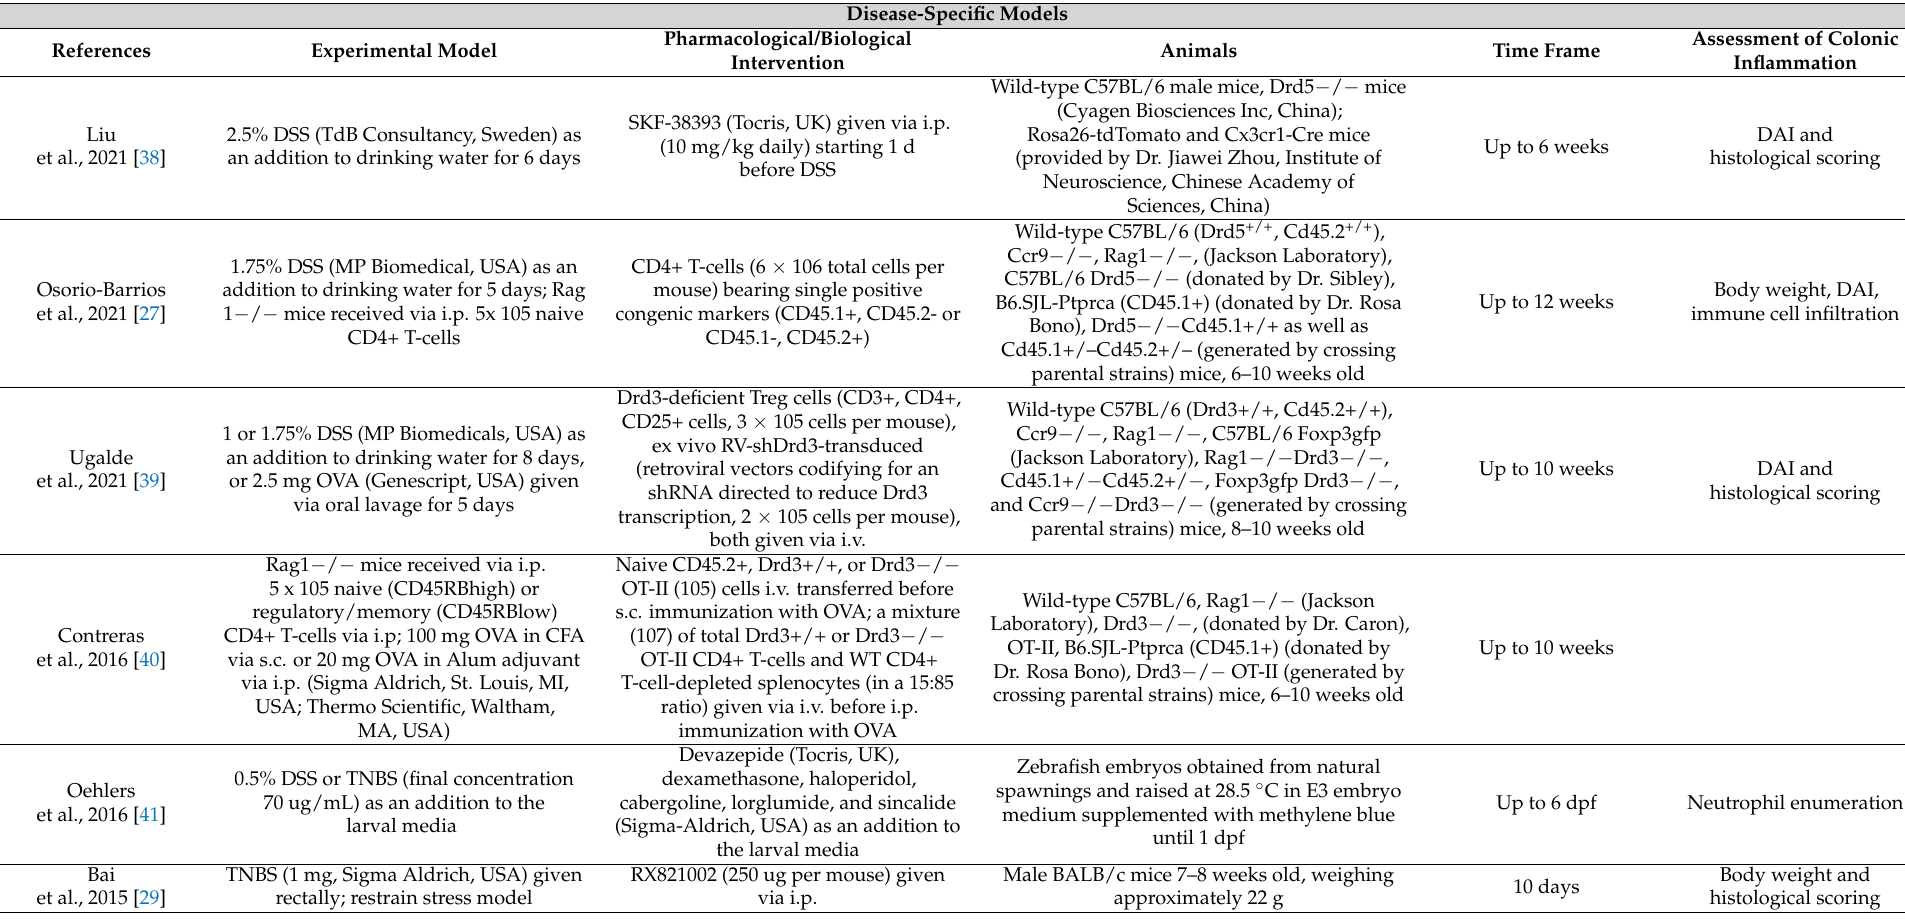
Table 2. Animal studies included in the analysis. Abbreviations: 6-OHDA: 2,4,5-trihydroxyphenethylamine; DAI: disease activity index; DNBF: 2,4-dinitrofluorobenzene; DSS: dextran sulphate sodium; IA: iodoacetamide; MPO: mieloperoxidase; MPTP: 1-methyl-4-phenyl-1,2,3,6-tetrahydropyridine; TNBS: 2,4,6-trinitrobenzene sulfonic acid; routes of administration: i.p.: intraperitoneal; i.g.: intragastric; i.v.: intravenous; s.c.: